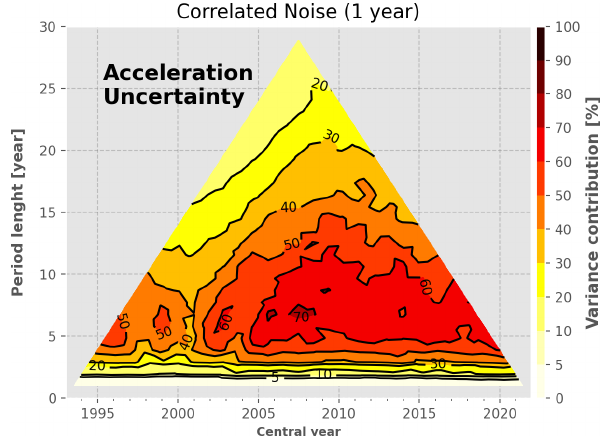
Figure B2. Variance contribution to the GMSL acceleration vari- ance of the high-frequency errors correlated at 1 year.